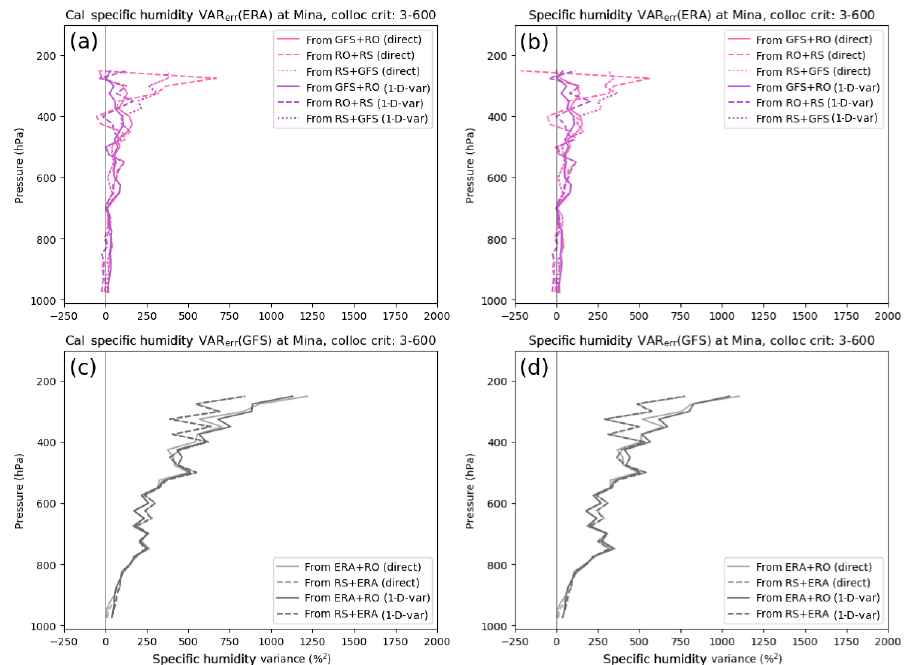
Figure A2. Estimated ERA and GFS specific error variances for ERA at Minamidait¯ojima (Japan) using calibrated data as in the TC method (a, c) and the uncalibrated data as in 3CH method (b, d) . For the TC method, the RO, RS, and GFS data sets are calibrated with respect to ERA. The following combinations of the four data sets are used: (ERA, RO, RS), (ERA, RO, GFS), and (ERA, GFS,